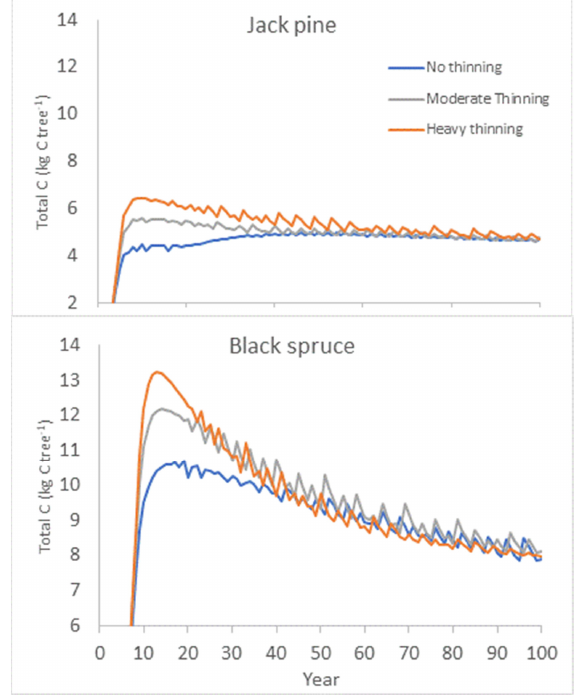
Figure 3. Simulated total carbon at a tree scale for jack pine and black spruce. The simulated thinning intensities include no thinning (6000 stem · ha − 1 ), moderate thinning (4000 stem · ha − 1 ), and heavy thinning (3000 stem · ha − 1 ).